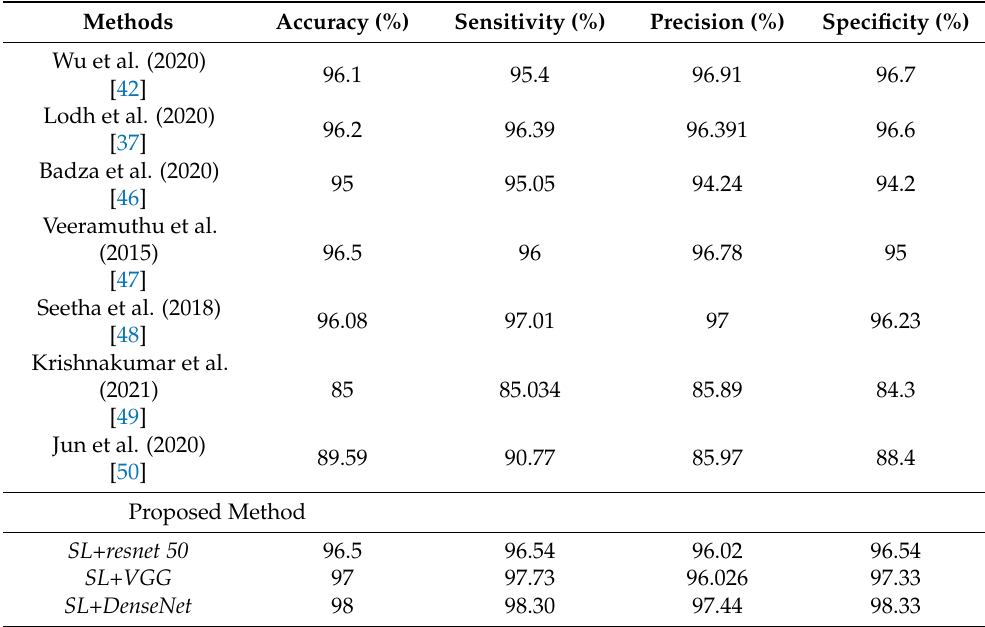
Table 14. Comparison with state-of-the-art methods for our proposed